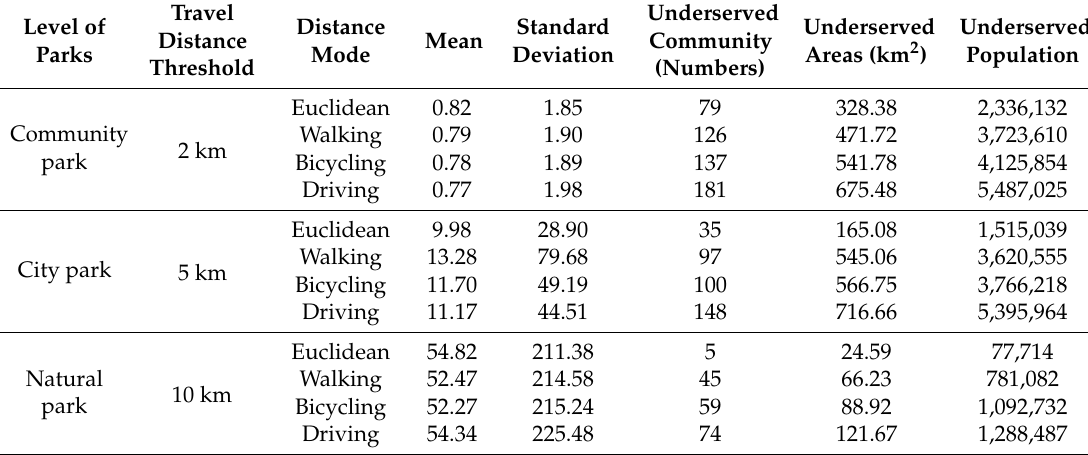
Table 4. Statistical comparison of the different levels of park accessibility under four types of travel